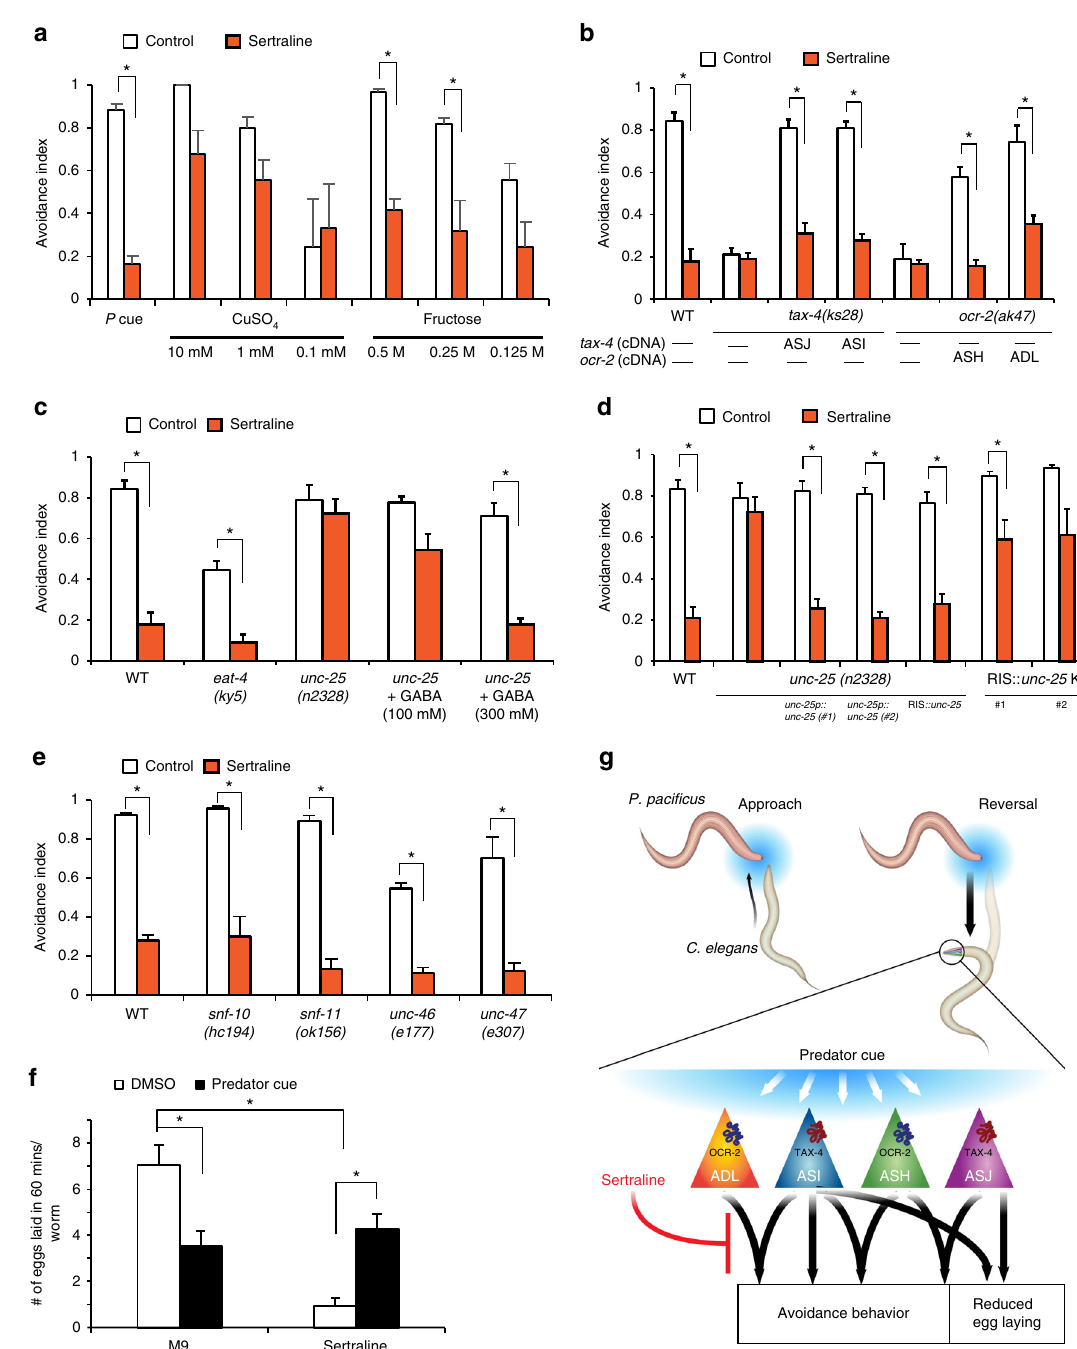
Fig. 4 Sertraline attenuates C. elegans responses to the P. paci fi cus predator. a Sertraline attenuates C. elegans respnses to predator cue and fructose, whereas copper avoidance is only slightly reduced. b The effect of sertraline is lost in tax-4 and ocr-2 mutants, and modulation is restored when TAX-4 is restored to either ASI or ASJ, or when OCR-2 is restored to ASH or ADL. c Sertraline requires GABA, but not glutamate signaling. Sertraline modulates avoidance responses of eat-4 (glutamate receptor), but not unc-25 (glutamic acid decarboxylase, required for GABA synthesis) mutants. Adding GABA exogenously to plates restores sertraline modulation to unc-25 mutants. d Defective unc-25 response is rescued by expressing wild-type unc-25 cDNA under the unc-25 promoter or a RIS-selective promoter. Knocking down unc-25 speci fi cally in RIS interneuron partially blocks sertraline modulation of predator avoidance. e Sertraline attenuates mutants in multiple GABA transporters including unc-47 , snf-11 , snf-10 , and unc-46 (a transmembrane protein that recruits UNC-47). f Animals were treated with predator cue or predator cue and sertraline for 30 min and egg-laying was monitored for 60 min after removal of these compounds. g C. elegans detects predator cue using sensory circuits consisting of ASI, ASJ, ASH, and ADL neurons that use CNG and TRP channels and act in a redundant manner to generate rapid avoidance. In contrast, CNG channels act in ASI and ASJ neurons to reduce egg laying over many minutes. Sertraline attenuates both predator-induced avoidance behavior and egg-laying behavior downstream of these sensory neurons. Averages of either n > 30 ( a – e ) or n > 35 ( f ) and s.e.m. are shown. * p < 0.05 compared to controls obtained using Fisher ’ s exact t -test with Bonferroni correction ( a – e ) and * p < 0.05 compared to controls obtained using a two-way ANOVA ( f